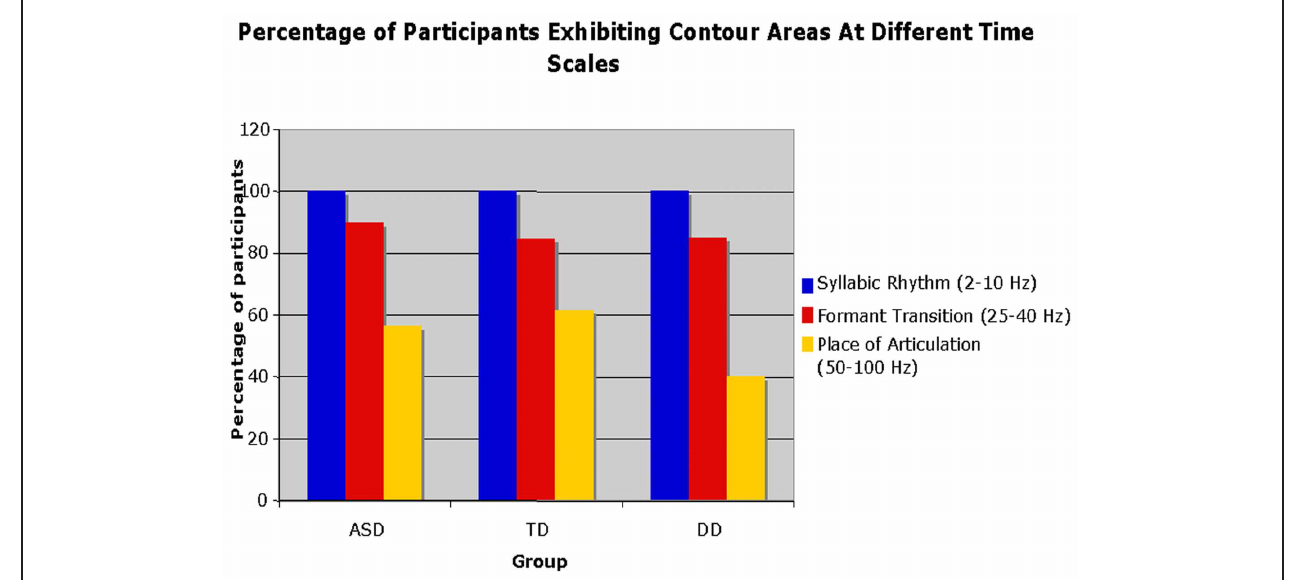
FIGURE 4 | The percentage of participants of each of the three groups (ASD, typical development, developmental delay) exhibiting contour areas at different time scales.